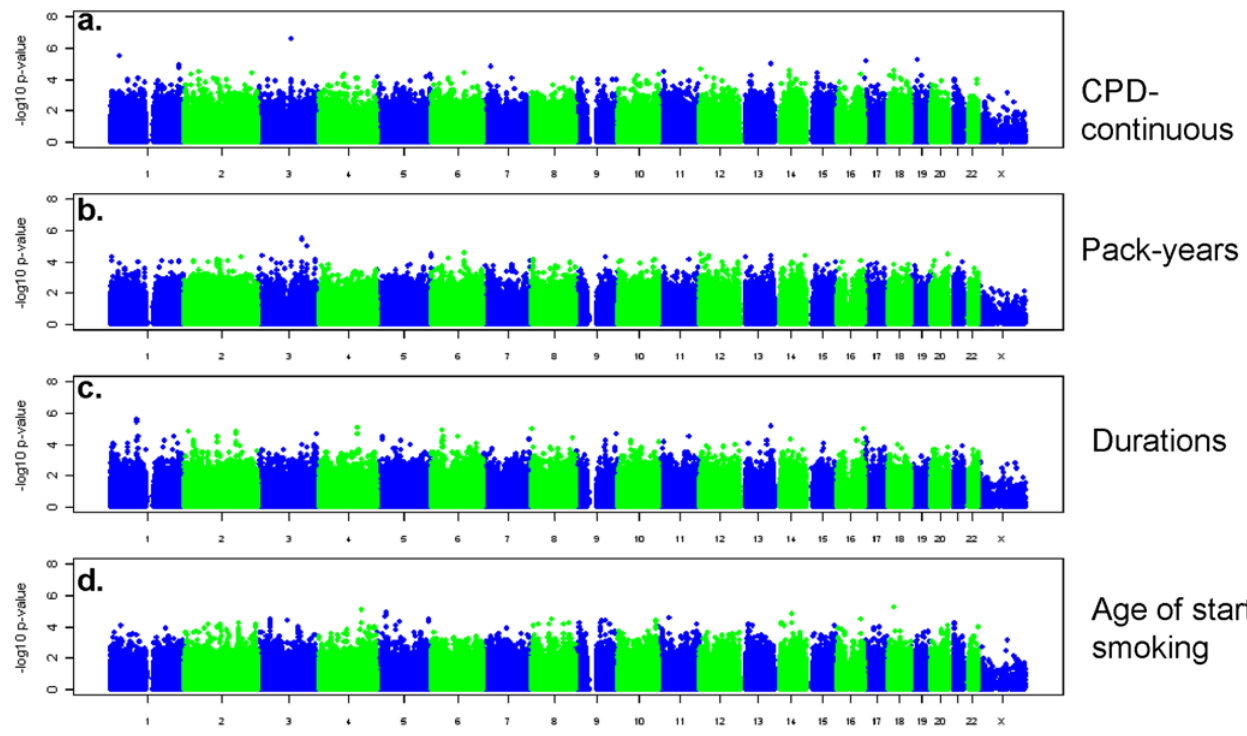
Figure 1. 2 log 10 p-values for association with seven continuous (Figure 1) and categorical (Figure 2) smoking behaviors. P-values are based on the combined evidence for association from both PLCO and NHS.